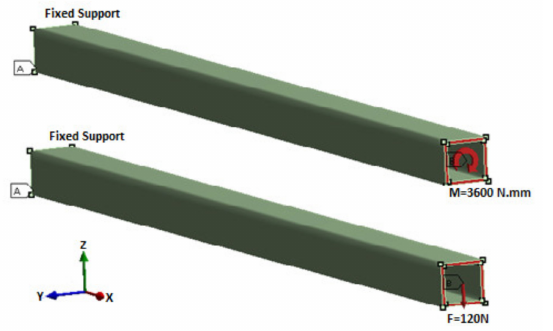
Figure 7. Finite element model geometry, applied loading, and boundary conditions (developed FE models consist of up to ~72,000 nodes and ~68,000 elements depending on laminate